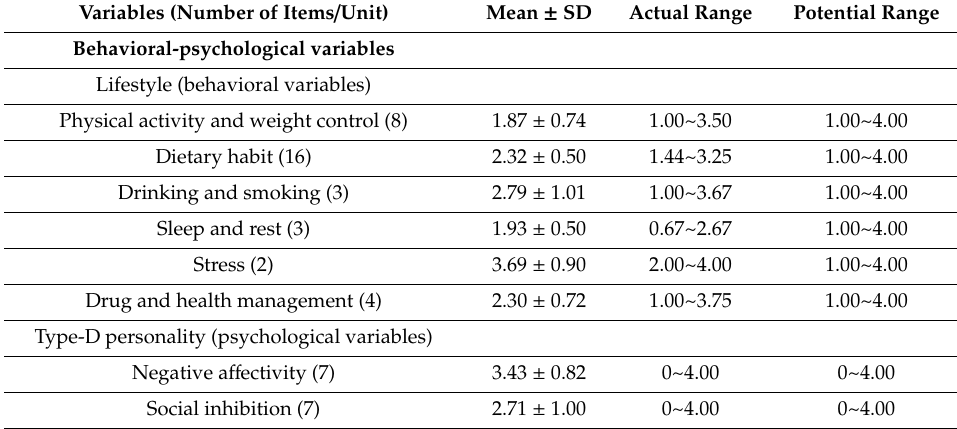
Table 2. Descriptive statistics of behavioral-psychological variables and predictors of CAD prognosis ( N =